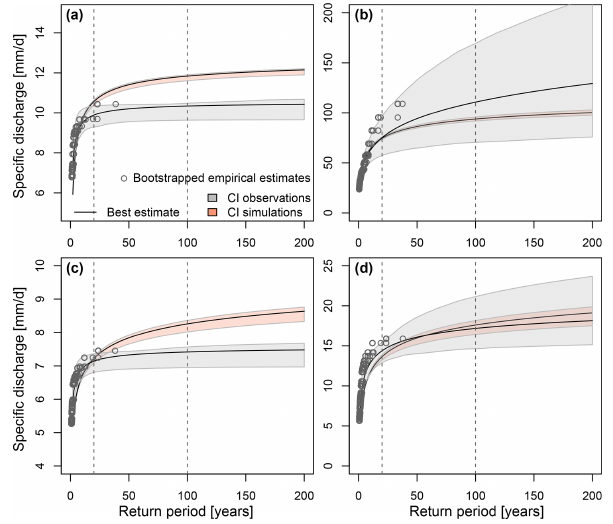
Figure 8. Observed vs. simulated flood frequency curves, including uncertainty bounds for four example catchments with different sea- sonality ratios. (a) Kemijoki–Ounasjoki. (b) Osterach–Reckenberg. (c) Rhine–Maxau. (d) Jouanne–Forcé. The observed and simulated best estimate frequency curves are indicated by black lines, the corresponding 90% confidence intervals by shaded polygons, and bootstrapped empirical return period estimates by grey dots. Confi- dence intervals are derived using